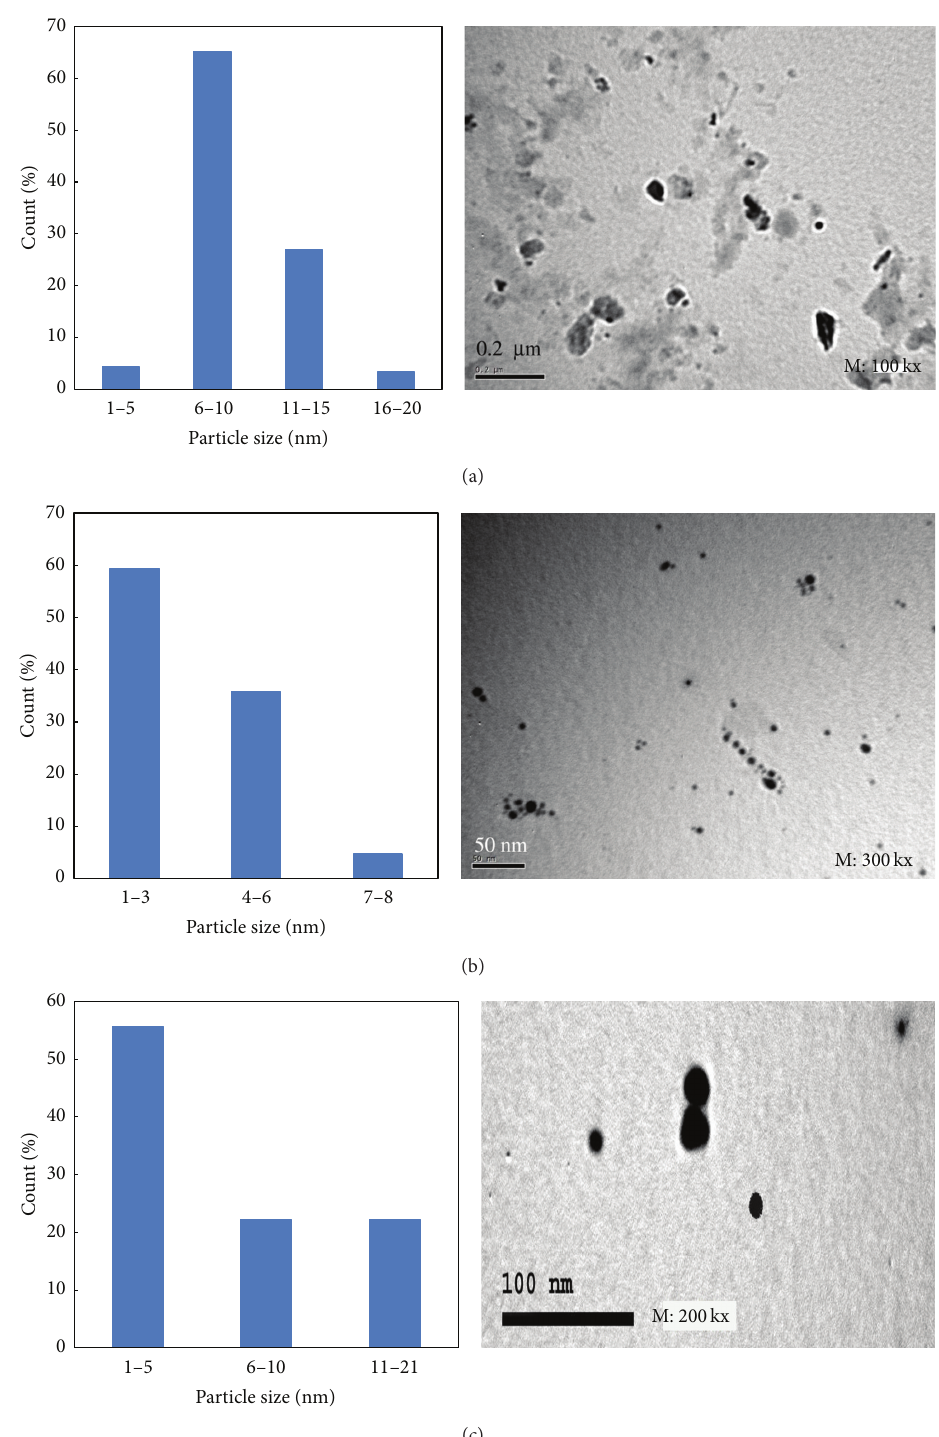
Figure 7: TEM micrograph and particle size distribution histogram of silver nanoparticles synthesized at different synthesis conditions. (a) [CMS], 50 g/L; [PI], 1g/L; [AgNO 3 ], 1g/L; temp., 30 ∘ C; time, 60 min.; M: L ratio, 1:20; pH, 7. (b) [CMS], 50g/L; [PI], 1g/L; [AgNO 3 ], 1.5 g/L; temp., 30 ∘ C; time, 60 min.; M:L ratio, 1: 20; pH, 7. (c) [CMS], 10 g/L; [PI], 1g/L; [AgNO 3 ], 1g/L; temp., 30 ∘ C; time, 60 min.; M: L ratio, 1:20; pH,